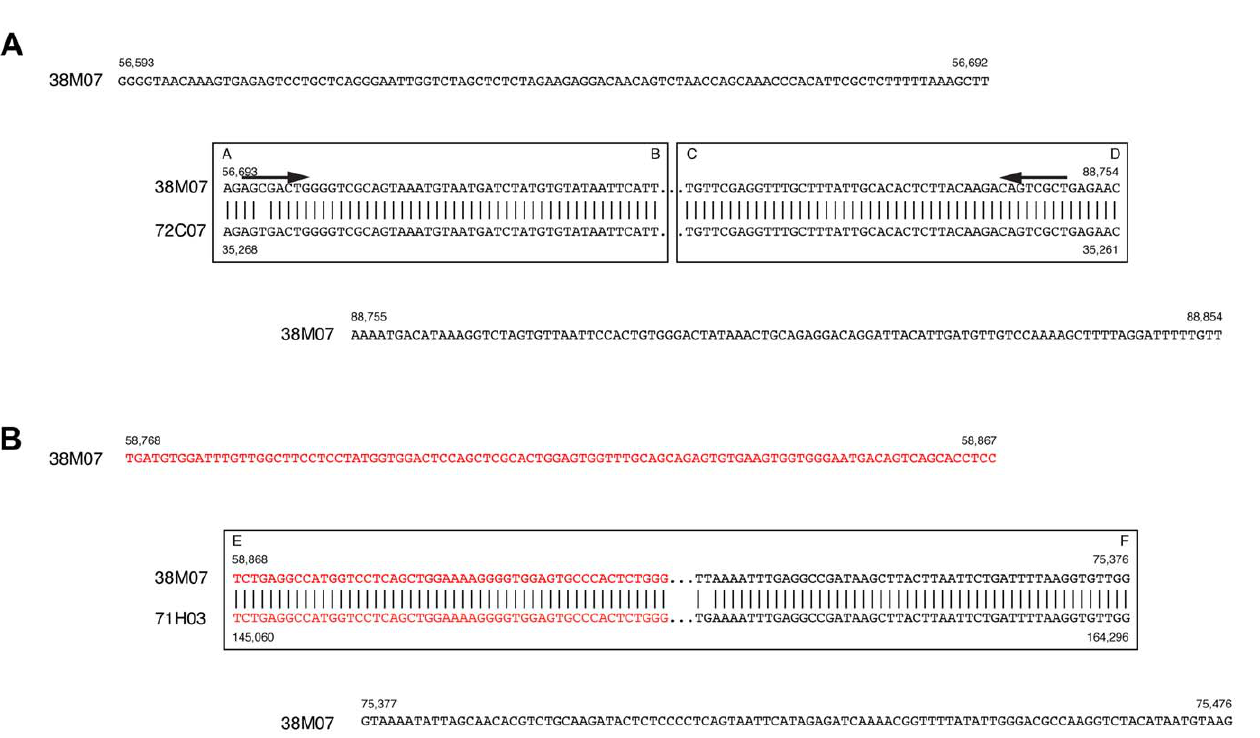
Figure S1 Comparison of BAC sequence contigs with the Broad genome assembly. Dotplots of the BAC sequence contigs against equivalent genomic scaffolds. (A) Orientation of 11 contigs for 38M07 against genomic scaffold_160. (B) 5 contigs of 71H03 against scaffold_19. (C) 3 contigs of 72C07 against